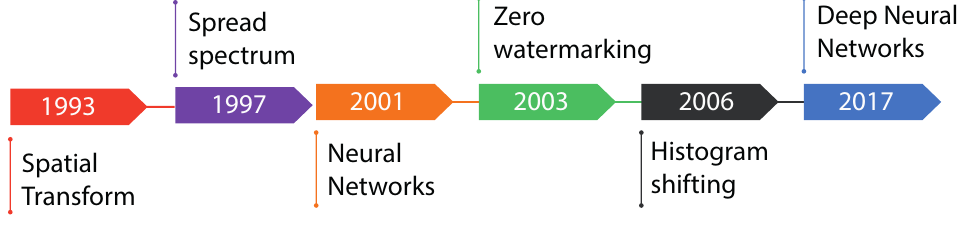
Figure 1. Watermarking operations